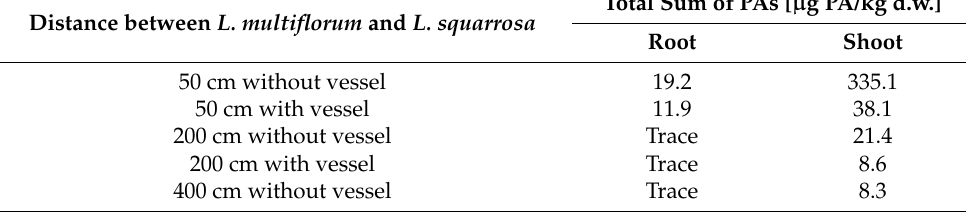
400 cm without vessel